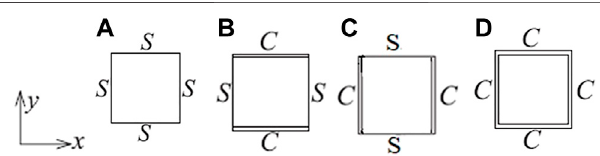
FIGURE 8 | Periodic unit (square plate, a/b = 1) with different edge boundary conditions (A) simply supported (SSSS), (B) axially fi xed and simply supported transverse direction (CSCS), (C) axially simply supported and fi xed transverse directions (SCSC), and (D) all edges fi xed (CCCC).